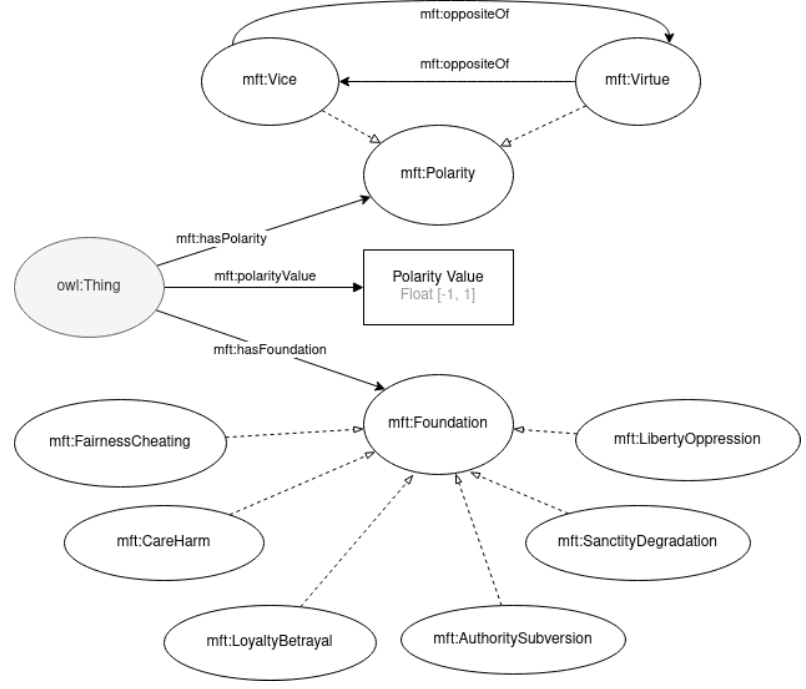
Figure 3. The morality